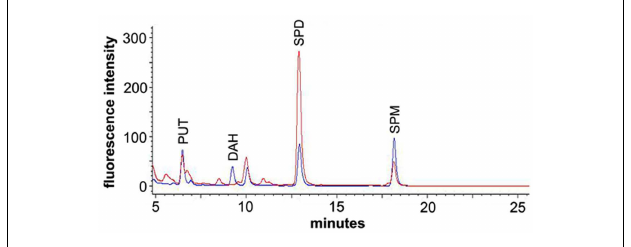
FIGURE 2 | Section of a chromatogram overlay for a PA standard mixture (blue) and a flower bud extract (red) after derivatization with FMOC-Cl. The standard mixture contained 10pmol each of putrescine (PUT), diaminoheptane (DAH), spermidine (SPD), and spermine (SPM).